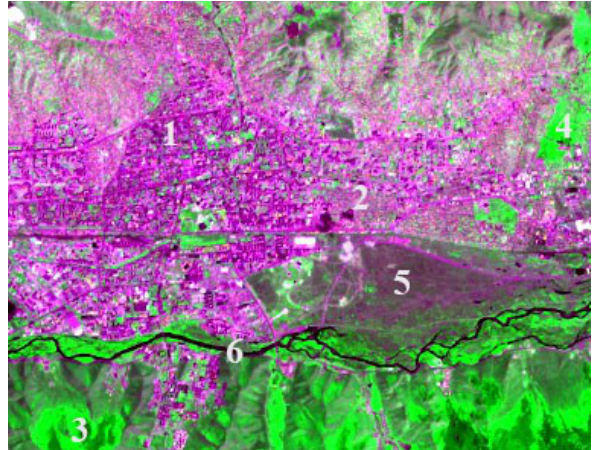
Figure 1. 2016 Landsat 8 image of the selected part of Ulaanbaatar city. 1-built-up area; 2-ger area; 3-forest; 4-grass;